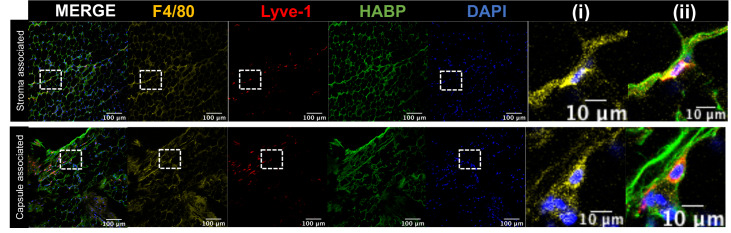
Lyve-1+ cells localize to HA-enriched ECM in the mammary gland.Mammary glands were stained for F4/80, Lyve-1 and HABP to confirm that Lyve-1+ cells associated with HA are also F4/80+. Insets show higher magnification.